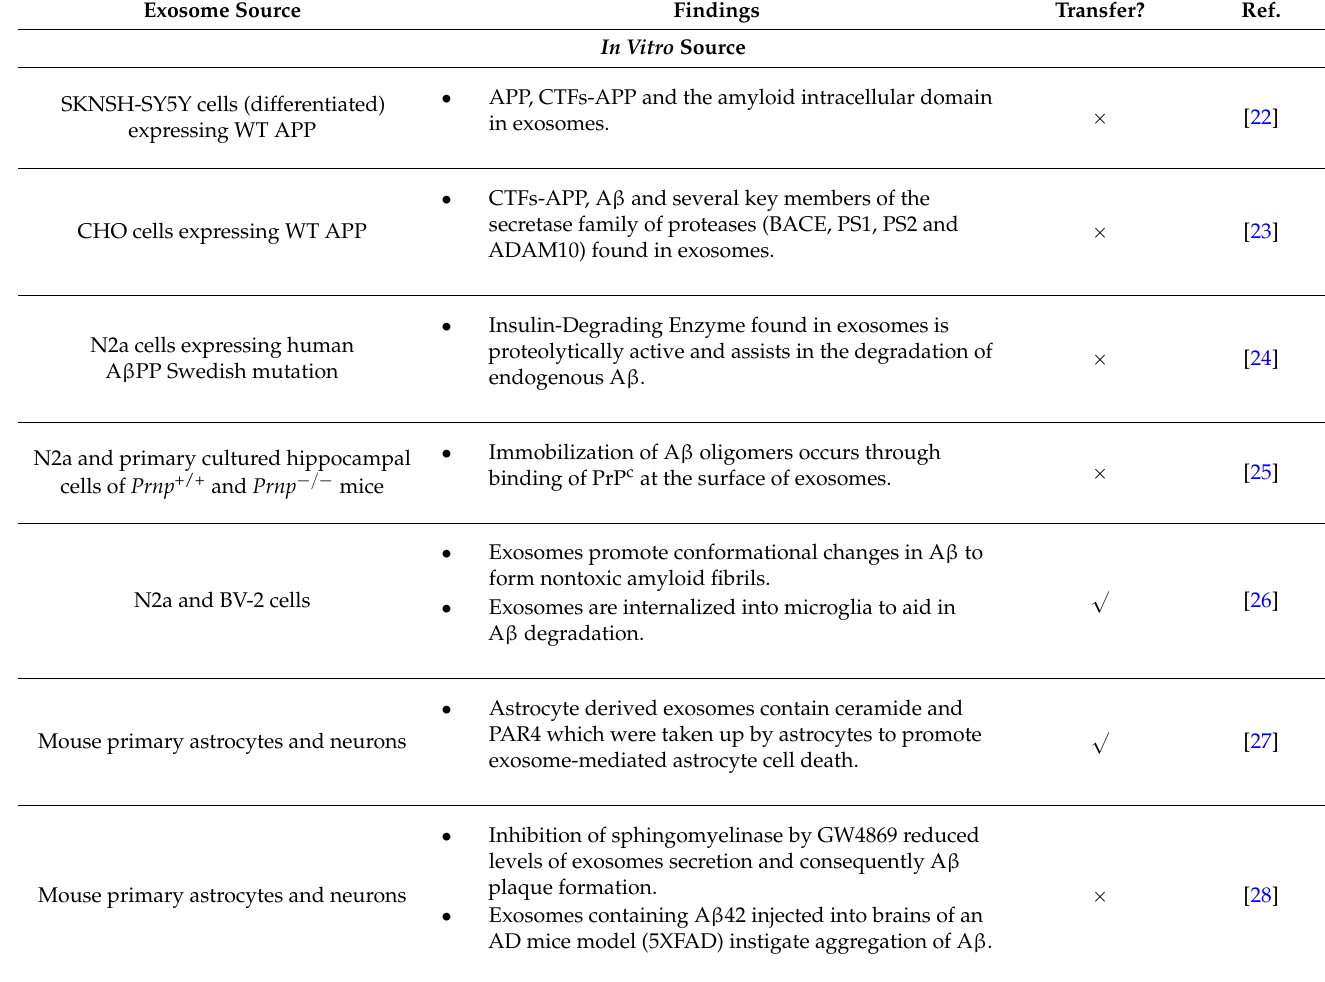
Table 1. Studies pertaining to amyloid- β , exosomes and Alzheimer’s